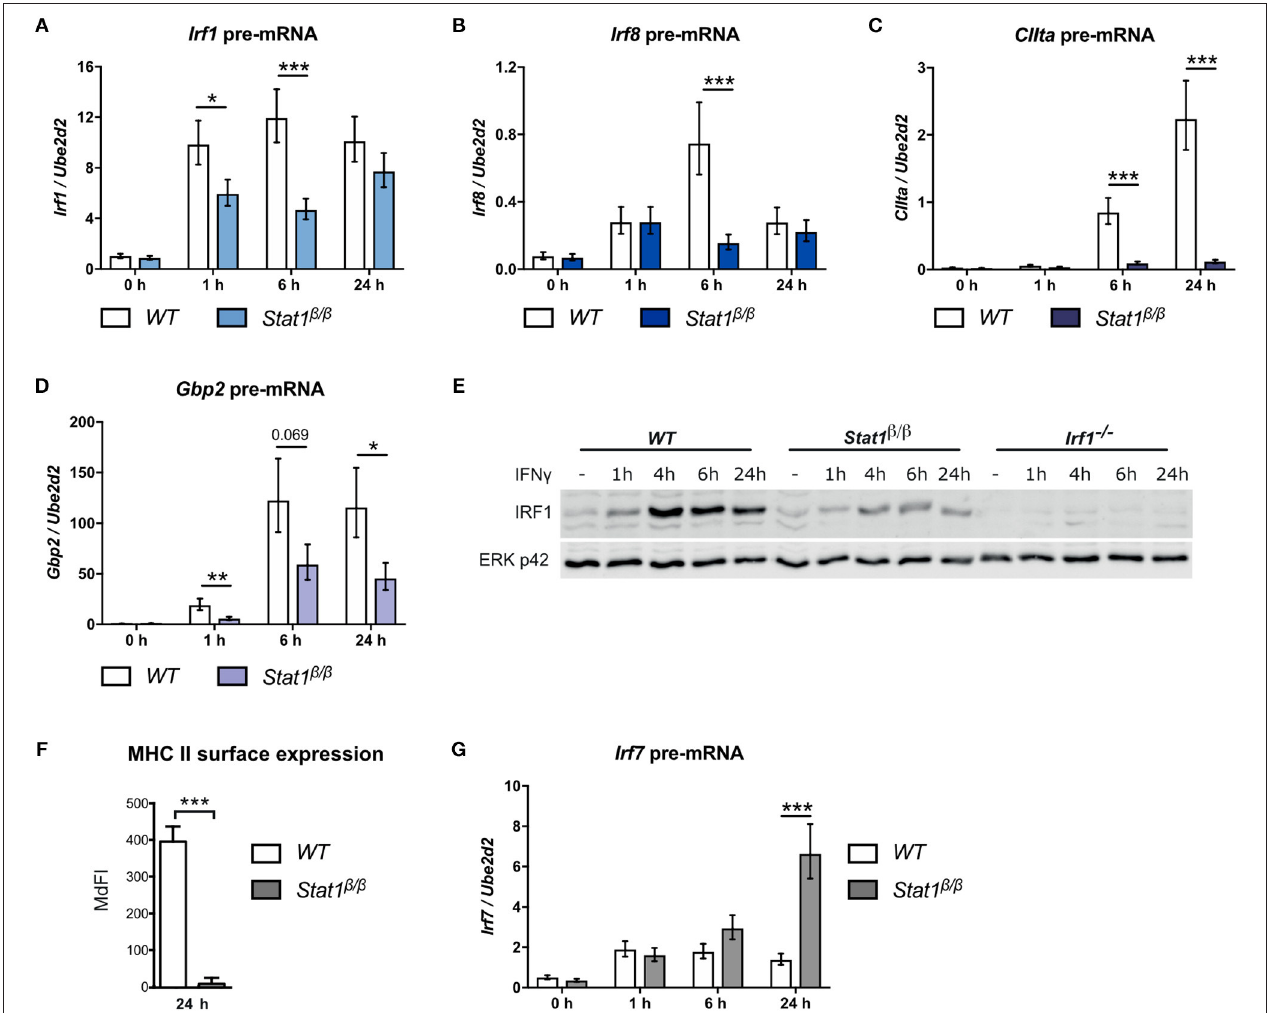
FIGURE 1 | Transcriptional activity of STAT1 β at the Irf1, Irf8, CIIta , Gbp2, and Irf7 genes. BMDMs from WT and Stat1 β/β mice were stimulated with IFN γ for the times indicated or left untreated (0h, -). Total RNA (A–D, G) or protein extracts (E) were isolated. Irf1 (A) , Irf8 (B) , CIIta (C) , Gbp2 (D) , and Irf7 (G) pre-mRNA expression was determined by RT-qPCR. Data were normalized to the housekeeping gene Ube2d2 . Mean values ± SE from three independent experiments are shown. (E) IRF1 protein levels were determined by Western blotting. ERK p42 was used as loading control. Data are as representative of two independent experiments. Original uncropped blots are shown in Supplementary Figure 1 . (F) BMDMs from WT and Stat1 β/β mice were stimulated with IFN γ for 24h. MHC class II surface levels were determined by flow cytometry. Median fluorescence intensities (MdFI) ± standard error (SE) from two independent experiments are shown. (A–D, F–G) * P ≤ 0.05 , ** P ≤ 0.01 , *** P ≤ 0.001 . Significances are only indicated for the comparisons between